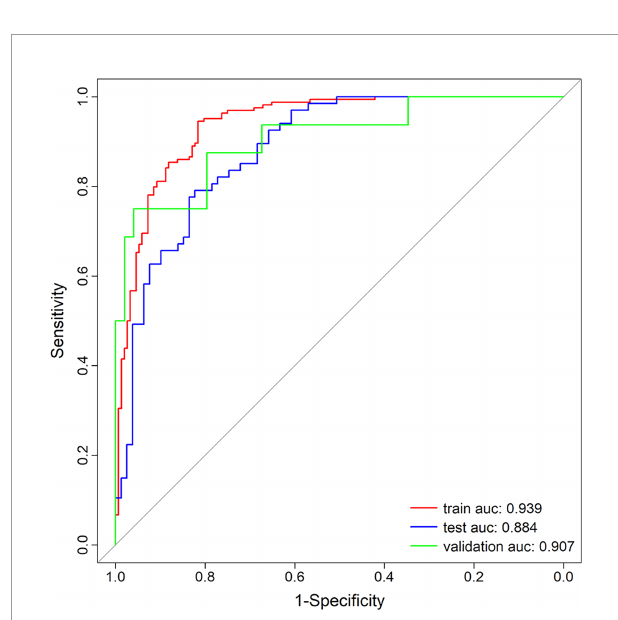
FIGURE 6 | Receiver operating characteristic (ROC) curves of the radiomics nomogram.